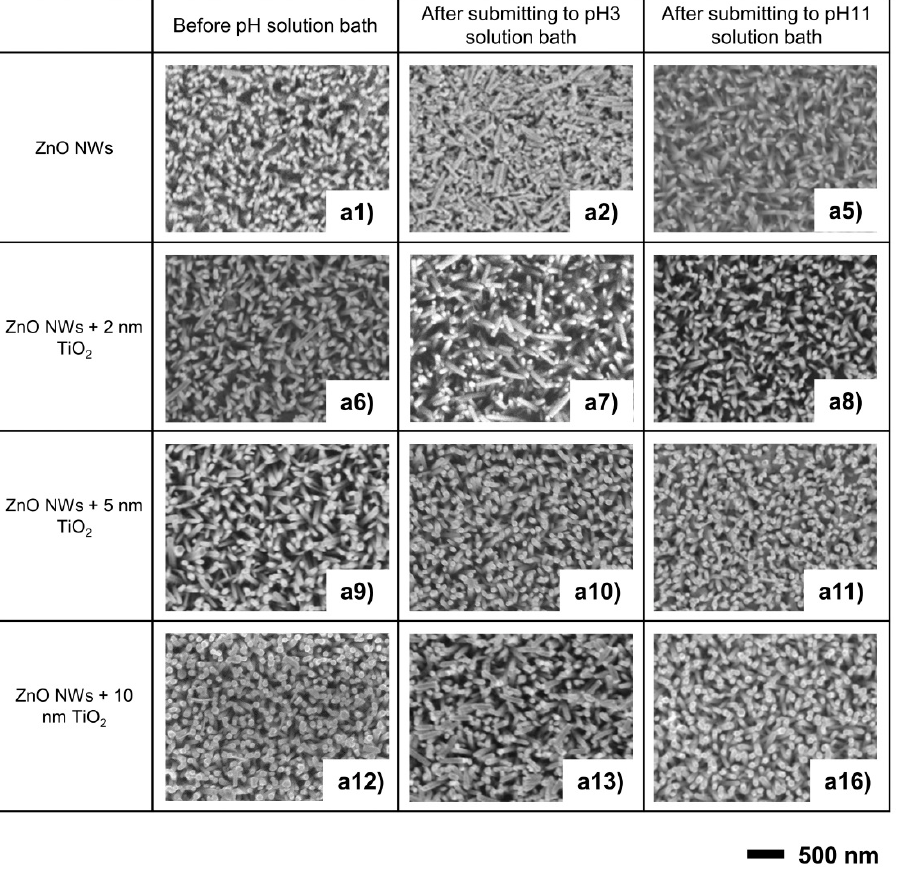
Figure 2. SEM images of the effect of TiO 2 coating thickness on ZnO NWs in strong acid/alkaline aqueous solutions.